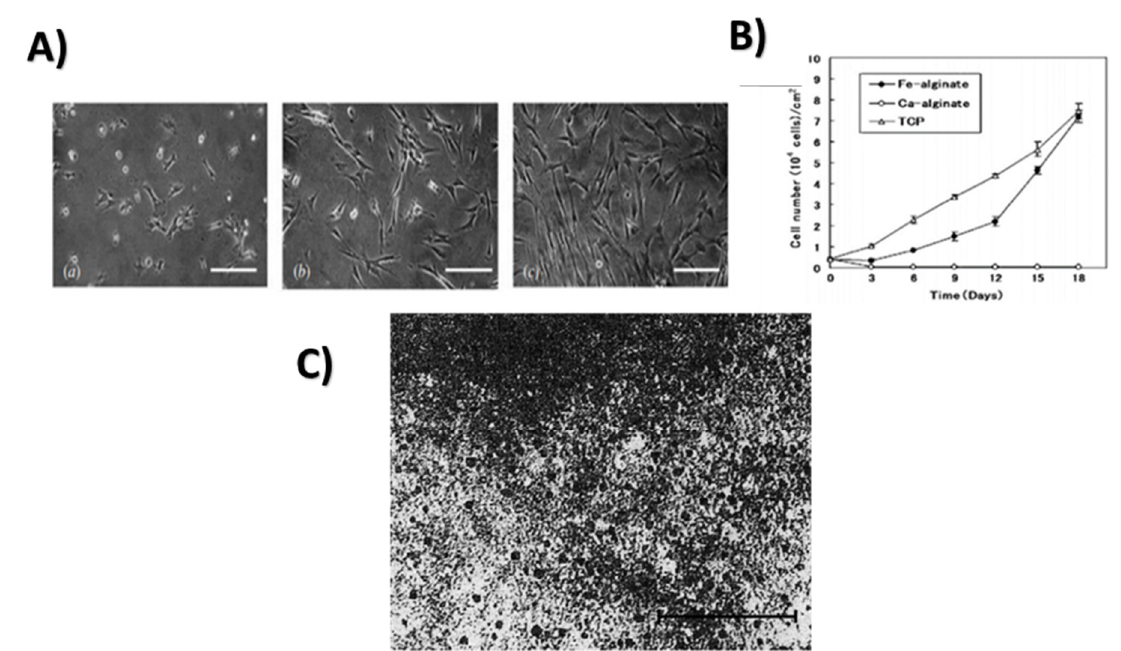
Figure 14. ( A ) shows photomicrographs of NHDF cultured on Fe-alginate films. Phase-contrast micro-graphs were taken for Ca-alginate films ( a ) at 4 h (left,), ( b )1 day (middle), ( c ) 3 days (right) after cell seeding. Bar equals 200 µm in micrographs. ( B ) shows the proliferation of NHDF on Fe- and Ca-alginate films, and TCP. The numbers of attached cells were counted at 3, 6, 9, 12, 15, and 18 days after cell seeding. Adapted from [222]. Reproduced with permission from IOP Science. ( C ) shows a transmission electron micrograph of a Fe(III)–chitosan compound obtained from a solution of pH 4.6, at a metal-to-ligand ratio of 1:1, showing electron-dense spheres of FeOOH, with particle sizes ranging from approximately 5 to 10 nm. The scale bar represents 100 nm. Adapted from [223]. Reproduced with permission from ACS.